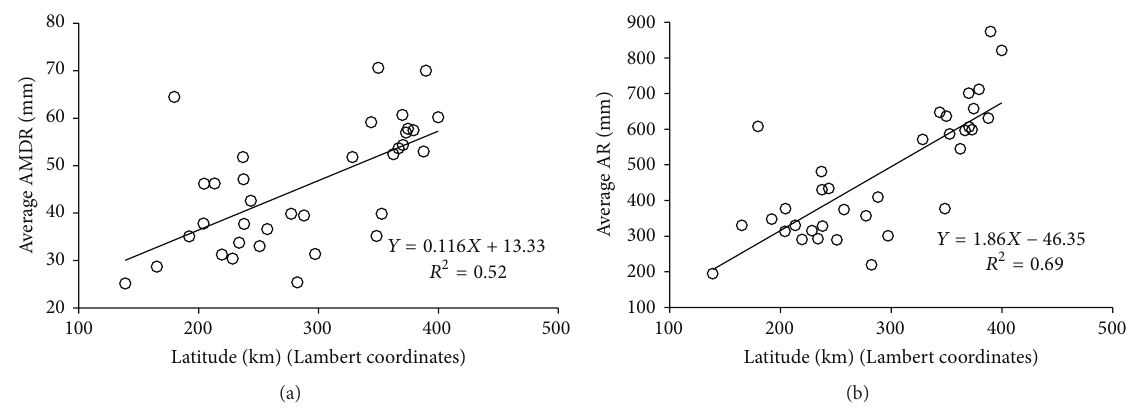
Figure 2: Relationship of AMDR (a) and AR (b) with latitude in northern Algeria.